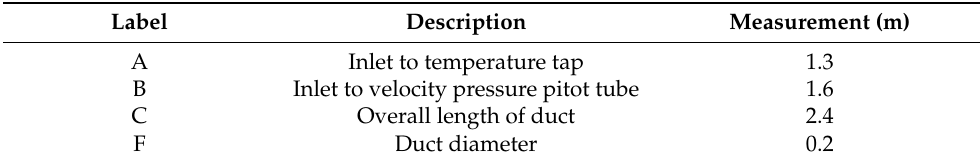
Figure 2. Test stand configuration and DAQC system in ADL for DGFCH test. Table 2. Dimensions of the test duct in Figure